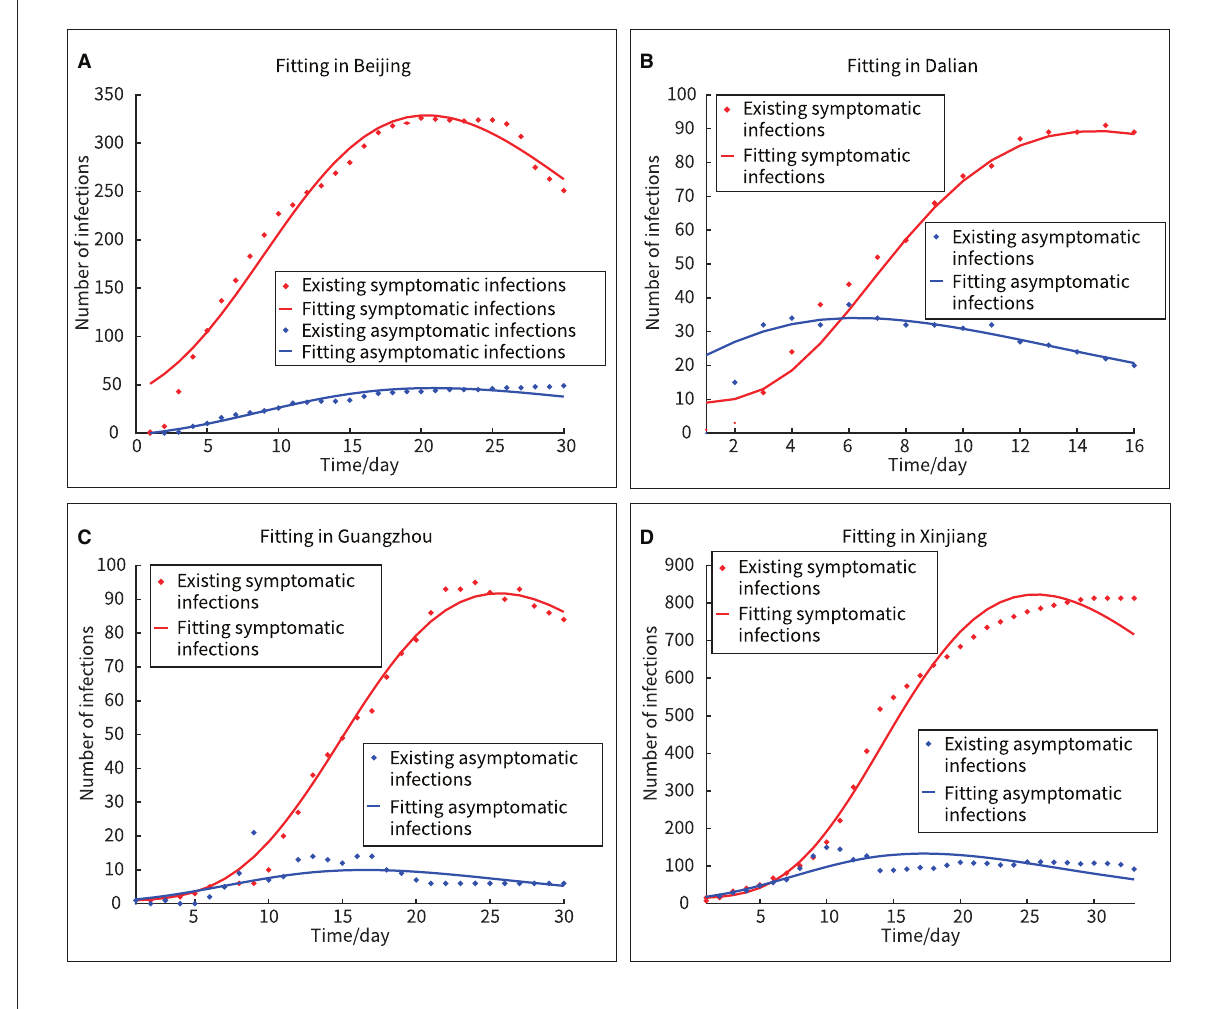
FIGURE5 Fitting of four outbreaks of symptomatic and asymptomatic infections. (A) Beijing, (B) Dalian, (C) Guangzhou, (D) Xinjiang.